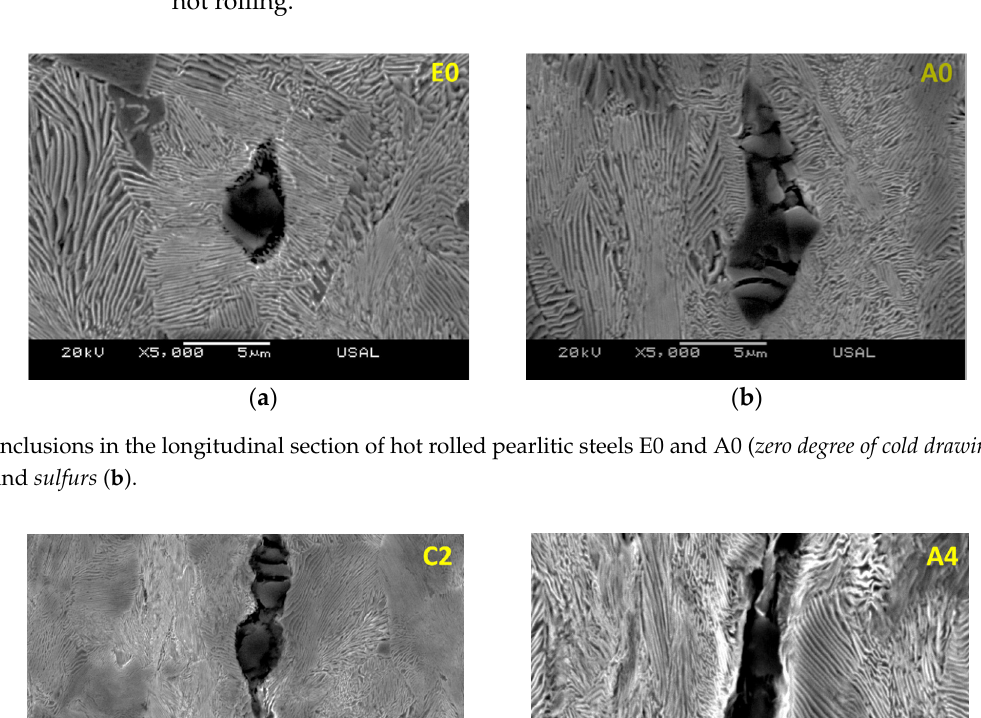
Figure 8. Inclusions in the longitudinal section of hot rolled pearlitic steels E0 and A0 ( zero degree of cold drawing ) showing oxides ( a ) and sulfurs ( b ).